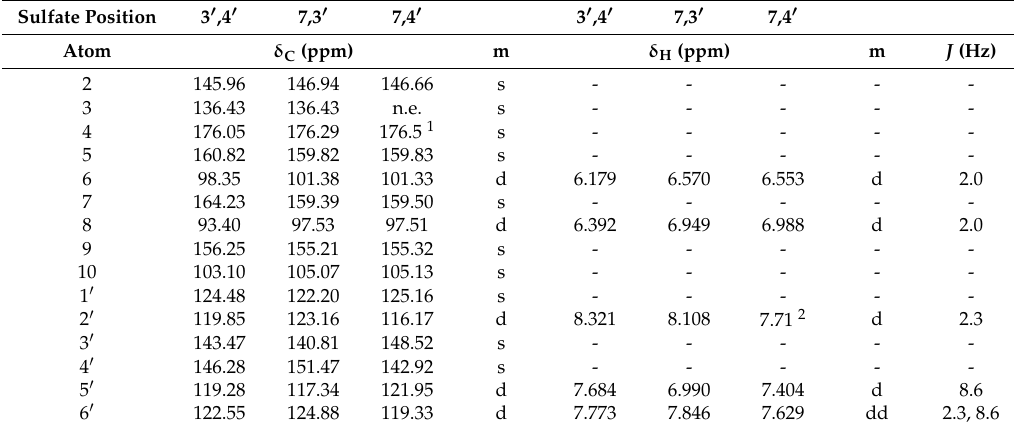
Table 2. 13 C and 1 H NMR data of quercetin-3 (cid:48) ,4 (cid:48) -di- O -sulfate, quercetin-7,3 (cid:48) -di- O -sulfate, and quercetin-